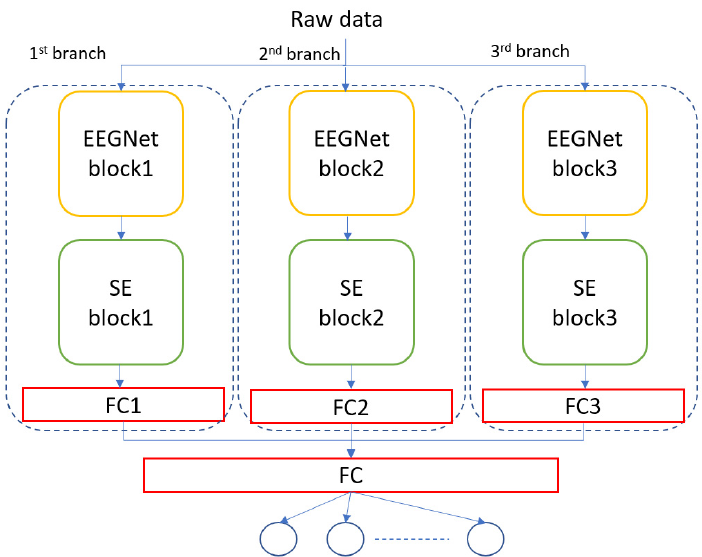
Figure 3. The architecture of the proposed model, MBEEGSE.